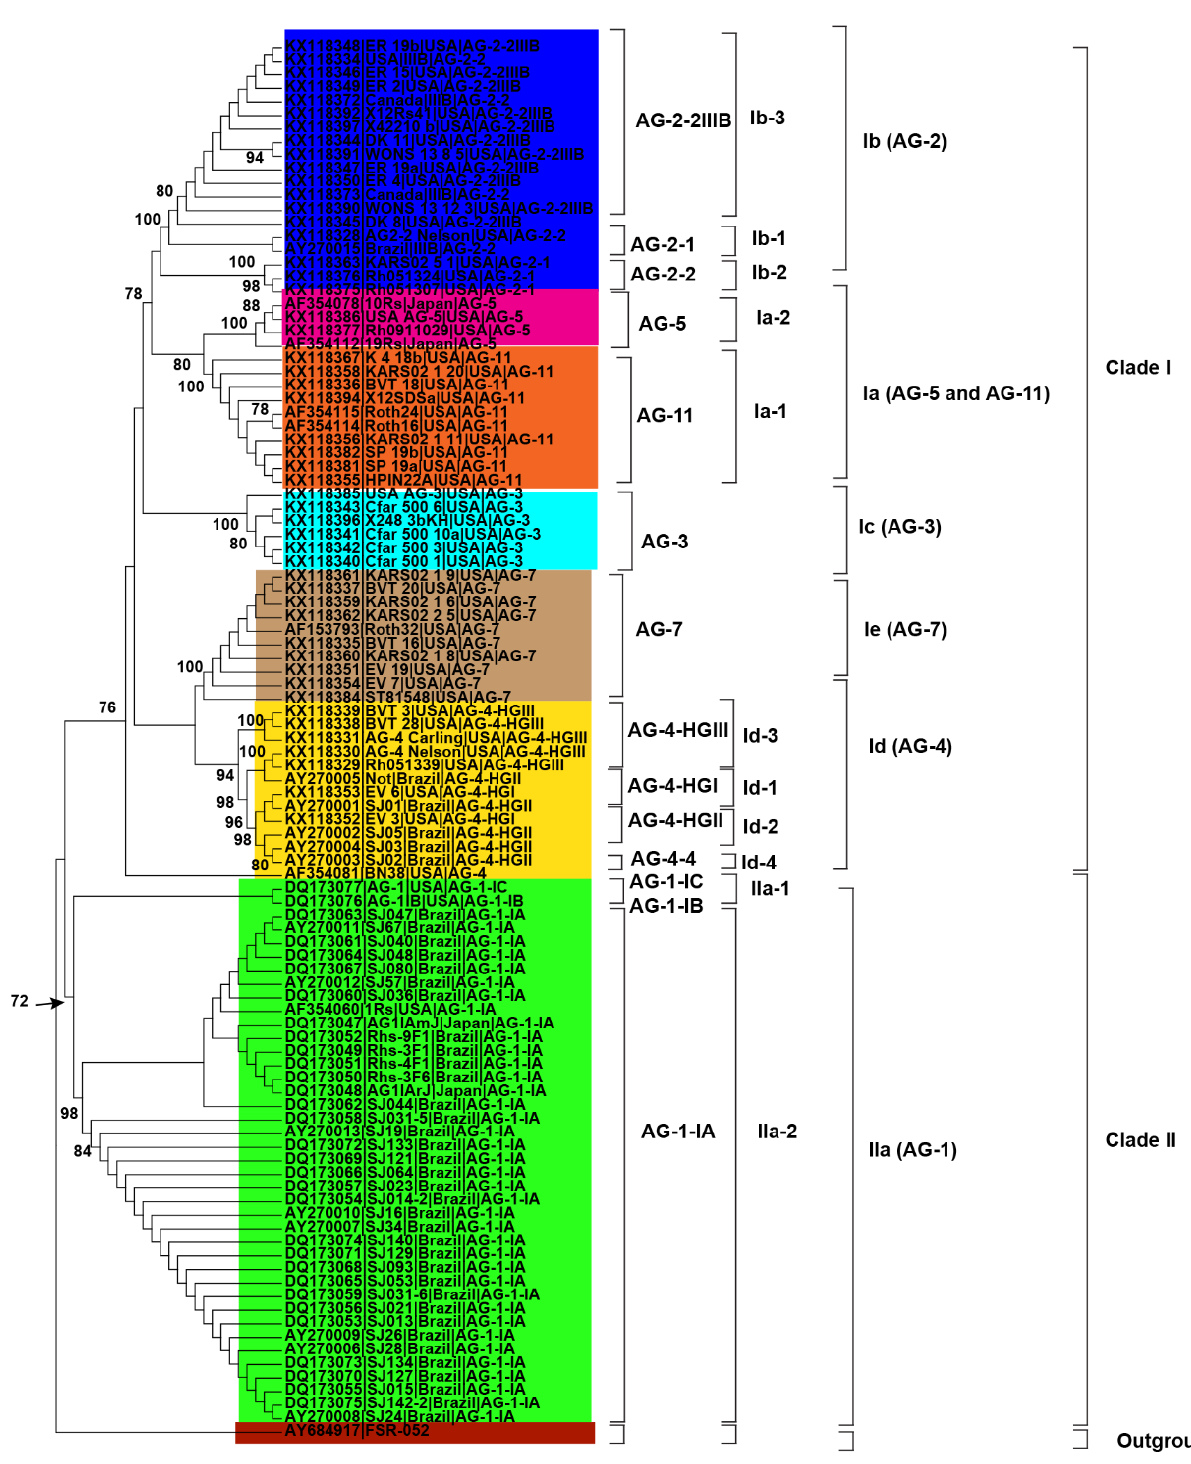
Figure 4. Genetic relatedness among the AG from soybean. Maximum parsimony (MP) analysis was used to build the trees. The accession numbers are followed by isolate, geographical origin and AG. Different colors show clades and/or subclades associated with AG. 1000 replications were used to bootstrap tree branches. Numbers at nodes indicate bootstrap values, and only those ≥ 70 are shown. The outgroup, Athelia rolfsii FSR-052 (GenBank Accession No. AY684917), was used to root the tree.